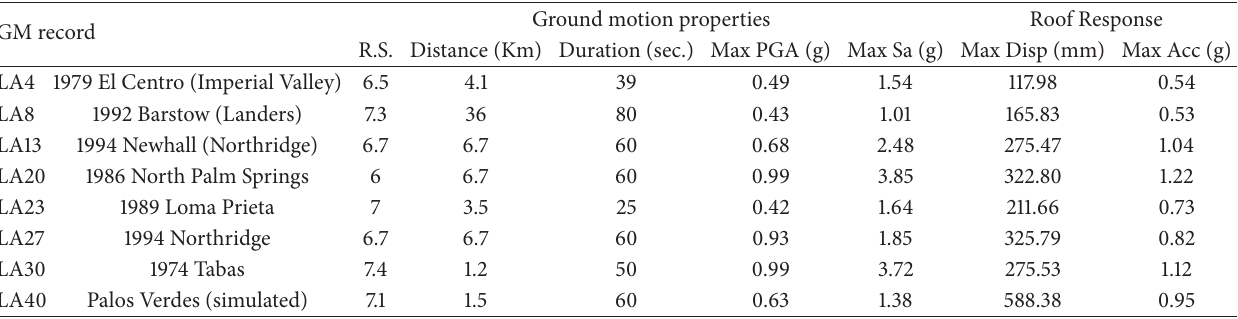
Table 1: GMs’ properties and statistical structures